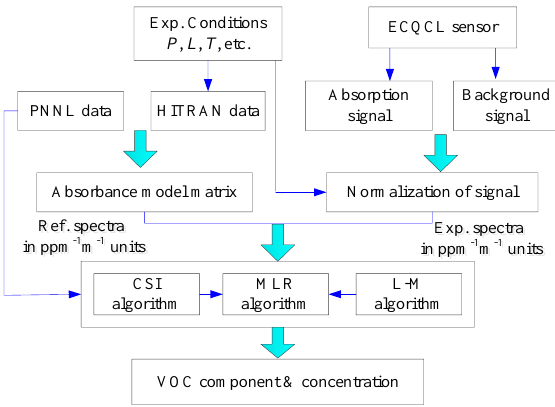
Figure 8. Flowchart of the spectral analysis model for volatile organic compounds (VOCs) spectral analysis [164].